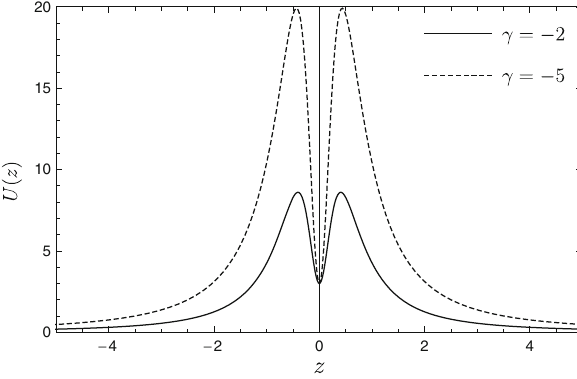
Fig. 7 Schrödinger potential in kink scenario for KR field coupled to Riemann tensor for some values of coupling constant γ